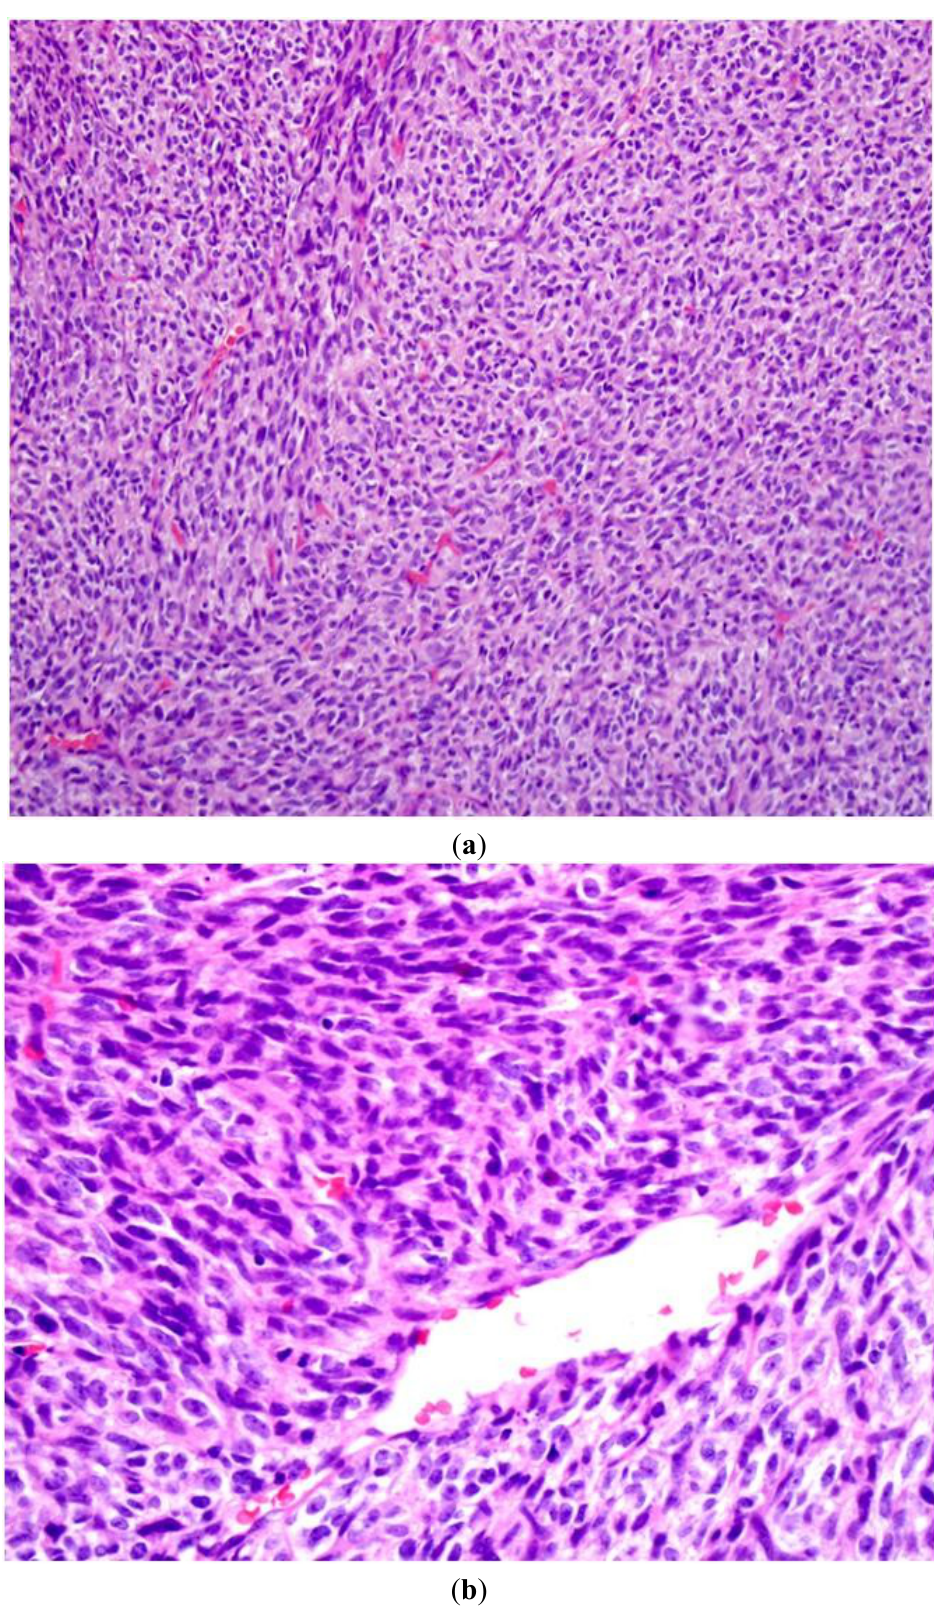
Figure 2. An intermediate power (200×) ( a ) view of routine hematoxylin and eosin (H&E stain) sections of a high-grade MPNST from an NF1 patient. A high cellularity of spindly (Schwann) cells intermixed with a fascicular growth pattern and little ―shredded carrot‖ collagen. High power (400×); ( b ) view shows increased cellularity, atypia, and mitotic